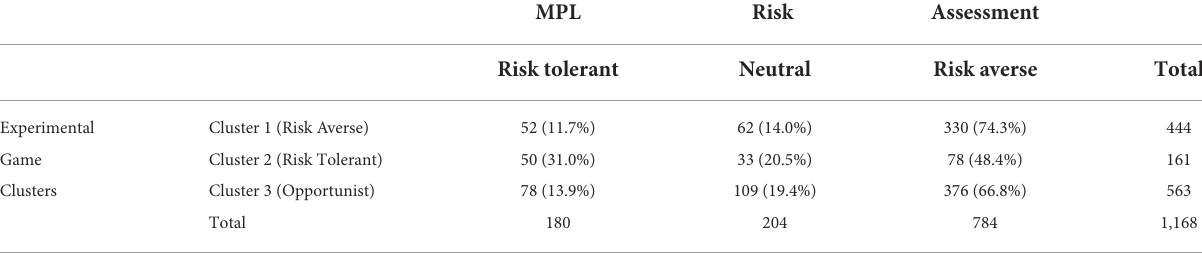
TABLE 3 Contingency Table comparing participants who were categorized using the game data clustering analysis (Rows) and classification using the MPL assessment (columns).